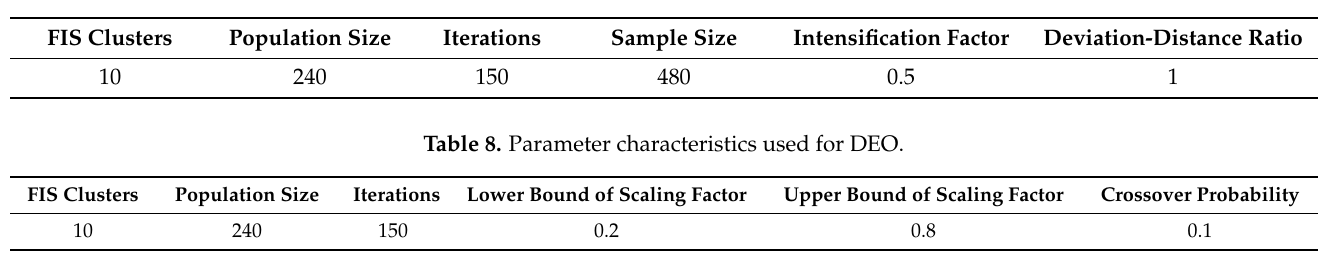
Table 7. Parameter characteristics used for ACO.